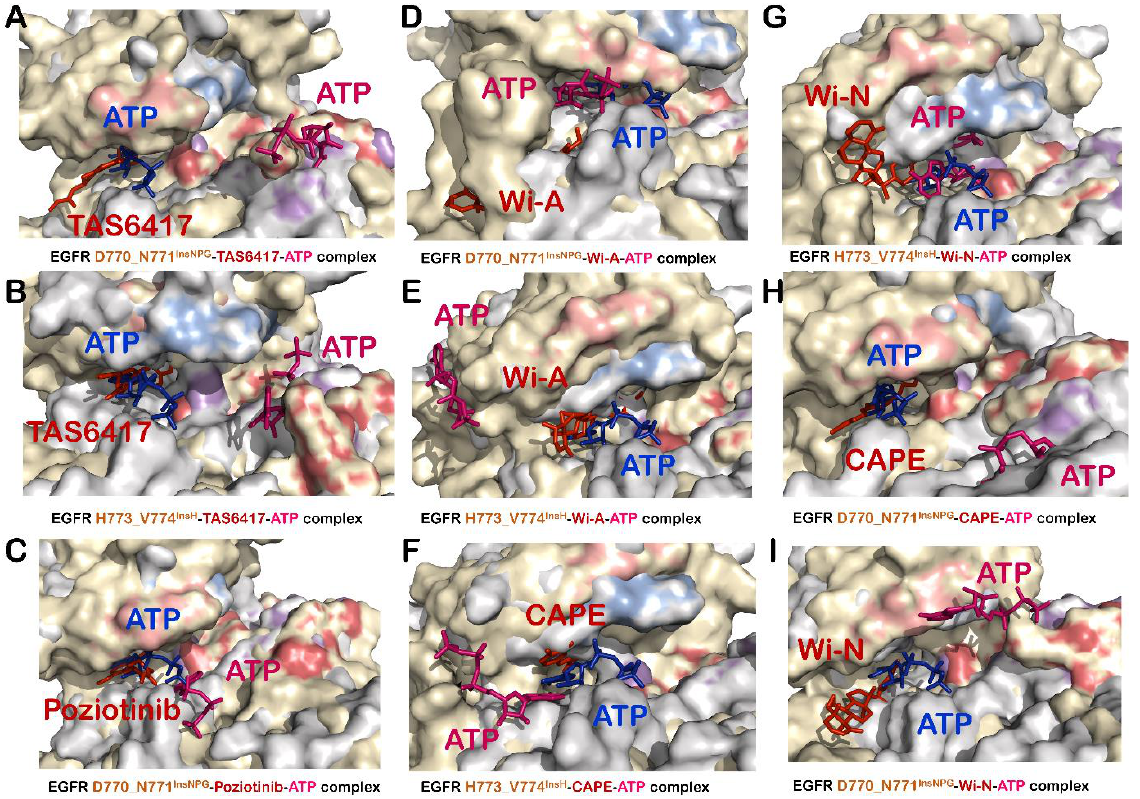
Figure 4. Superimposition of wildtype EGFR–ATP (grey-blue) complex with EGFR exon 20 insertion mutant–inhibitor–ATP (yellow-red-pink) complexes to unveil competition of inhibitors with ATP at ATP binding site of: ( A ) D770_N771 InsNPG